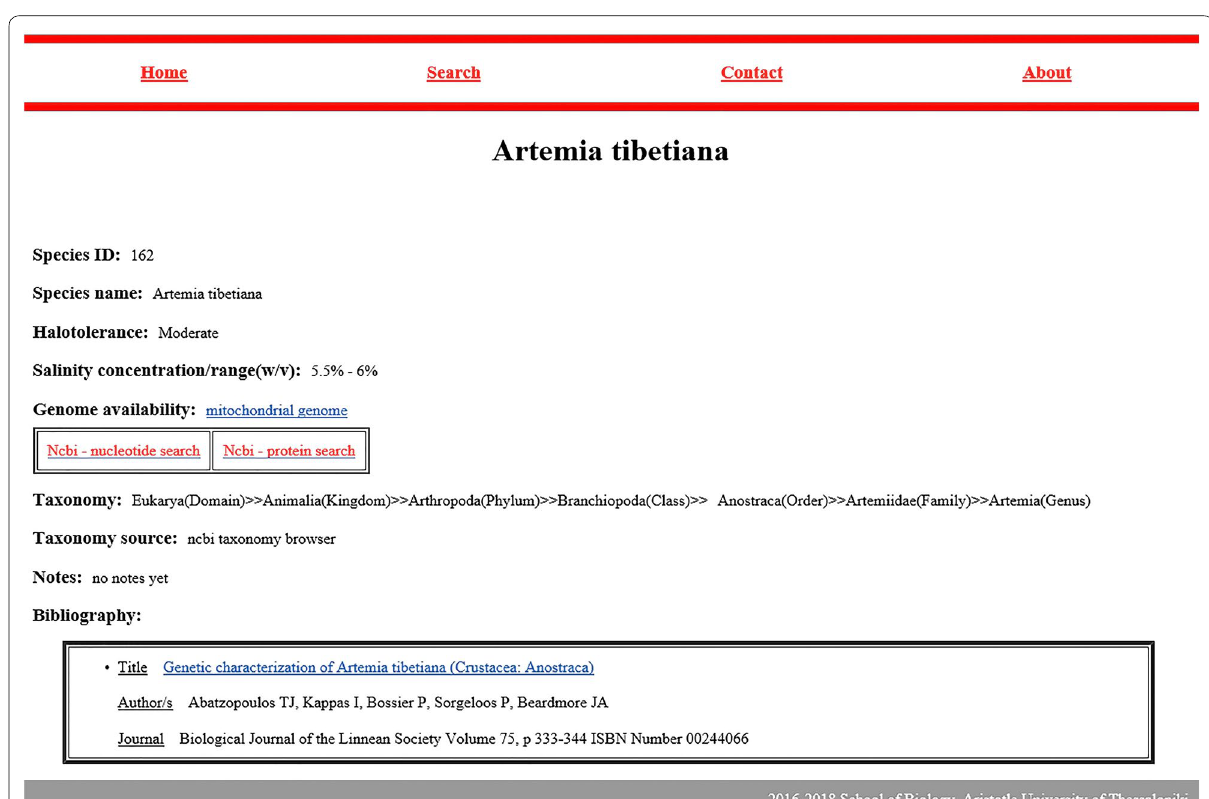
Fig. 5 The entry page for Artemia tibetiana